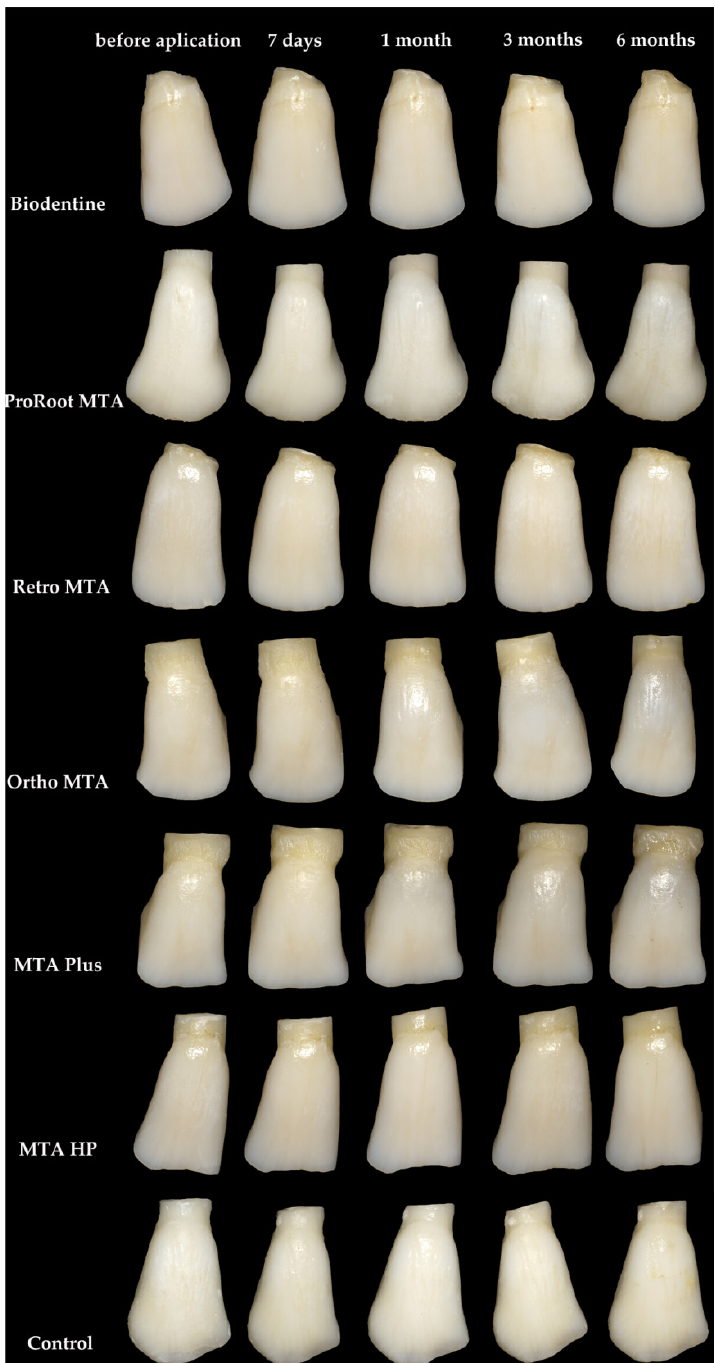
Figure 5. Representation of the bovine teeth samples.